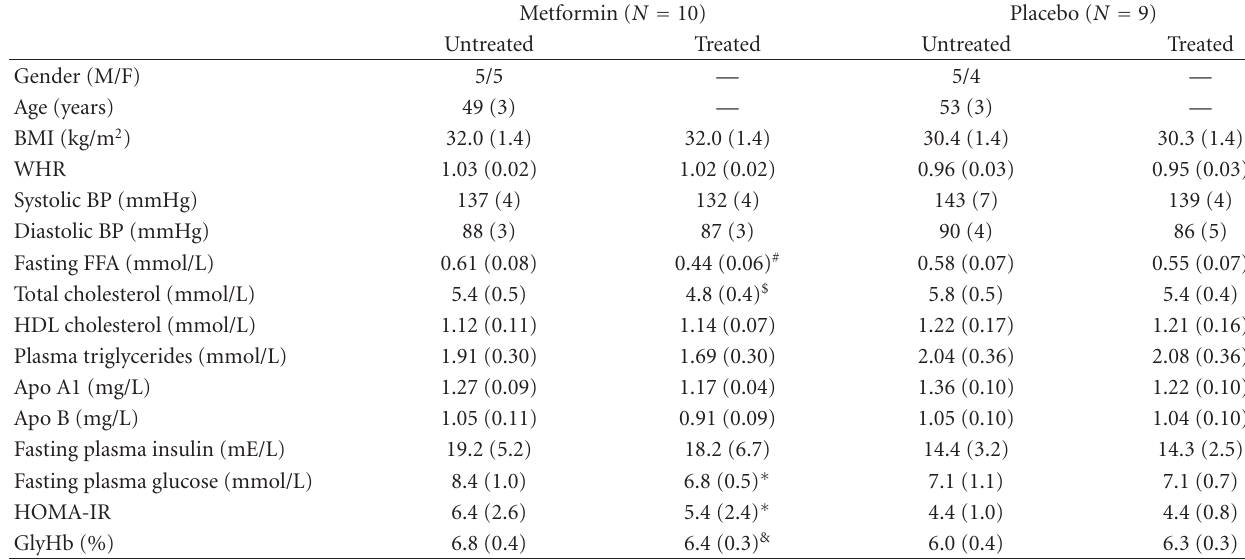
Table 1: Characteristics of patients included in the metformin and the placebo groups at baseline and six weeks after treatment. Data are given as mean (SEM) unless stated otherwise.